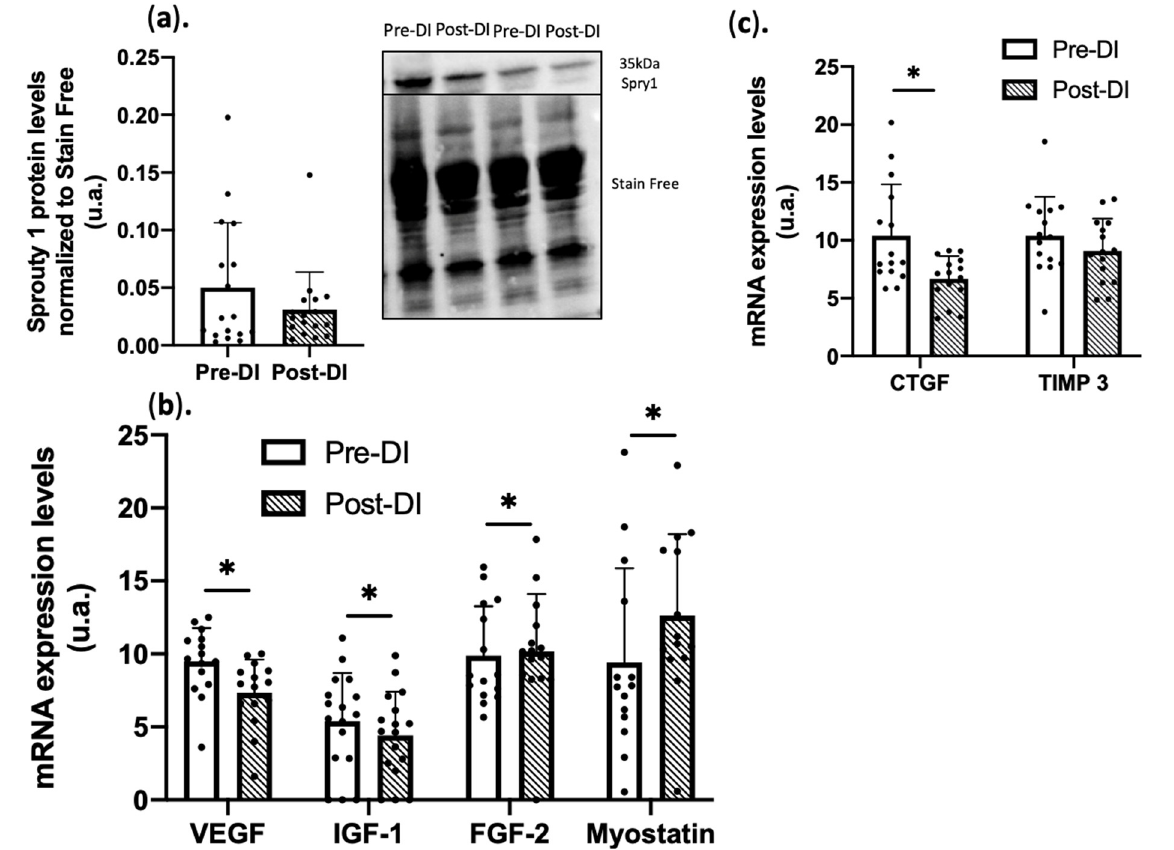
Figure 2. Key muscle microenvironment signaling components in VL biopsies before (Pre-DI) and after (Post-DI) 5 days of DI. ( a ) Sprouty 1 protein levels in Pre-DI and Post-DI muscle biopsies. n = 17/time point, data were normalized to the total protein staining using Stain-free technology; ( b ) Gene expression of ECM modulators in Pre-DI and Post-DI muscle biopsies. n = 14/time point for VEGF, Myostatin; n = 17/time point for IGF-1; n = 15/time point for FGF-2 ( c ) Gene expression of factors involved in the muscle microenvironment quality in Pre-DI and Post-DI muscle biopsies; n = 15/time point. * p <0.05, Paired t -test or Wilcoxon matched-pairs signed-rank test was performed according to normality.